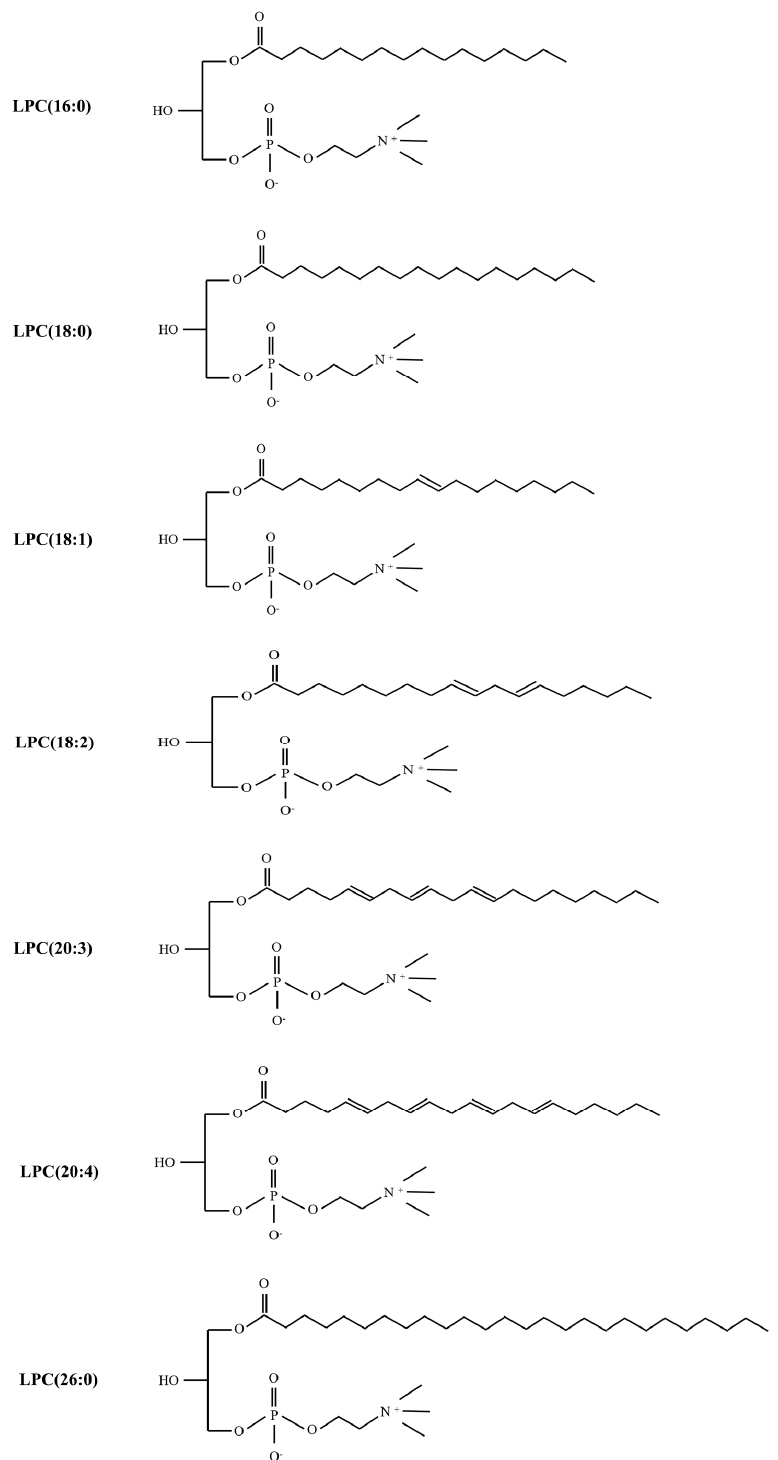
Figure 3. The structure of different LPC subtypes associated with chronic pain.